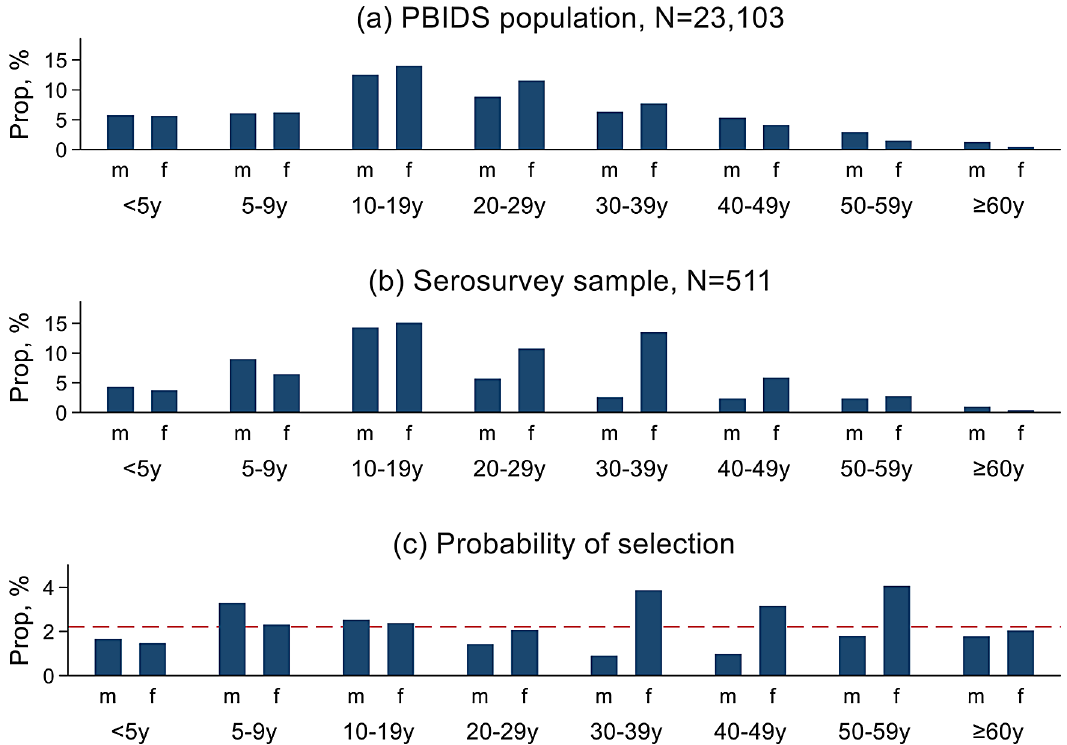
Figure 2. Figure showing age and sex distribution of (a) population-based infectious disease surveillance (PBIDS) population as of December 2020; (b) serosurvey participants; and (c) the probability of participant selection from the PBIDS population into the serosurvey. The red dashed line shows the overall expected probability of selection with bars above the red line indicating overrepresentation while those below the line denoting underrepresentation of the age-sex groups in the sero